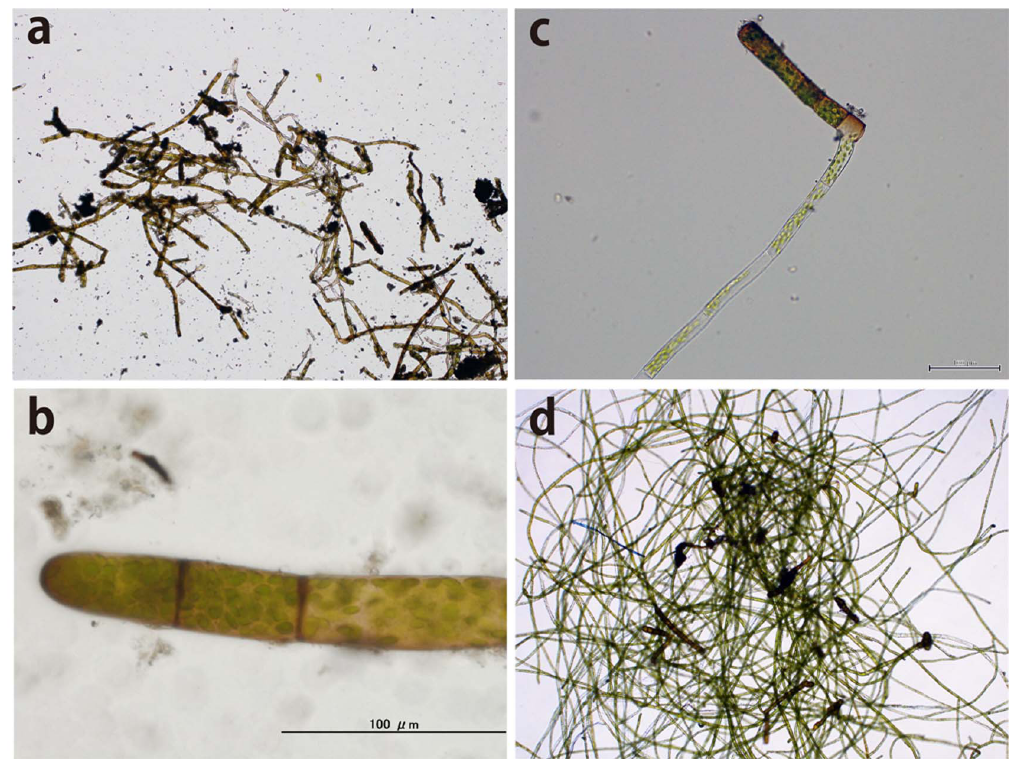
Figure 4. Cells of moss gemmae and protonemata. a,b) Moss protonemal cells formed the main frame of the GMGA (scale bar: 100 m m), c) Moss protonema grew from gemmae below 4 u C (scale bar: 100 m m), d) protonemal cells for molecular identification after incubation below 4 u C for 1 month in liquid Bold’s basal medium.